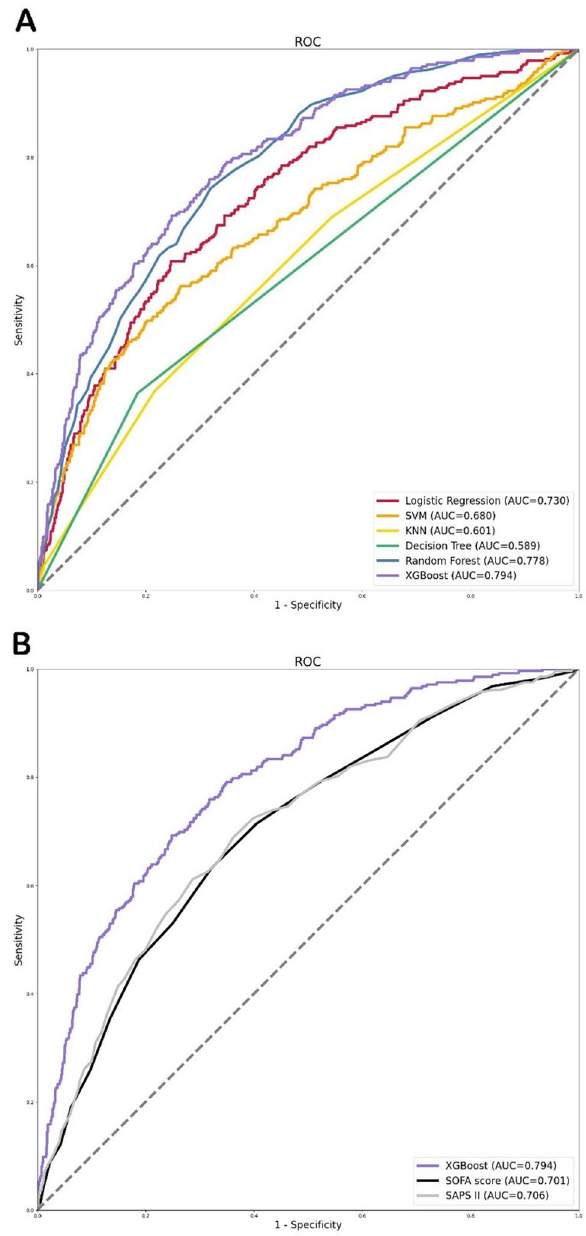
Figure 2. ROC curves for the ML models and the traditional severity of illness scores to predict in-hospital mortality. ( A ) ROC curves for the six ML models used to predict in-hospital mortality; ( B ) ROC curves for the traditional severity of disease scores used to predict in-hospital mortality. ROC Receiver operating characteristic, SVM Support vector machine, KNN k-nearest neighbors, AUC Area under the curve, SOFA Sequential organ failure assessment, SAPS II Simplified acute physiology score